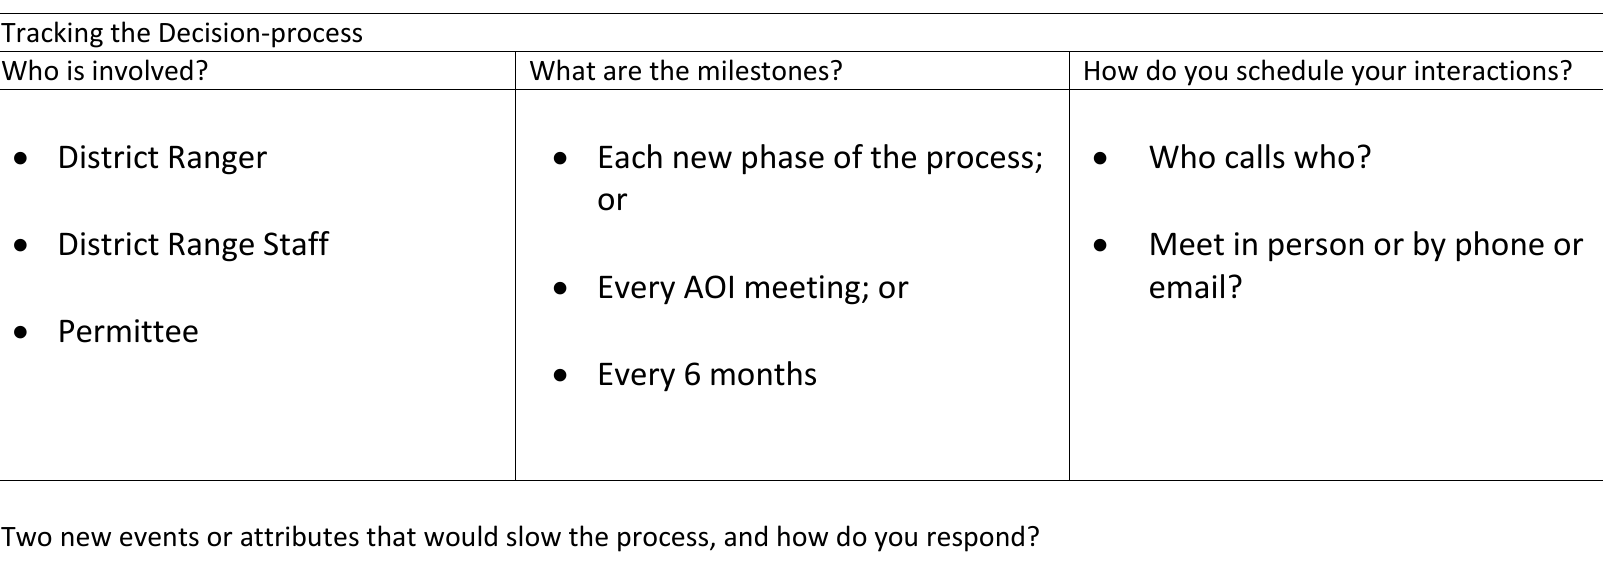
Figure 2 continued: Example of reverse page of